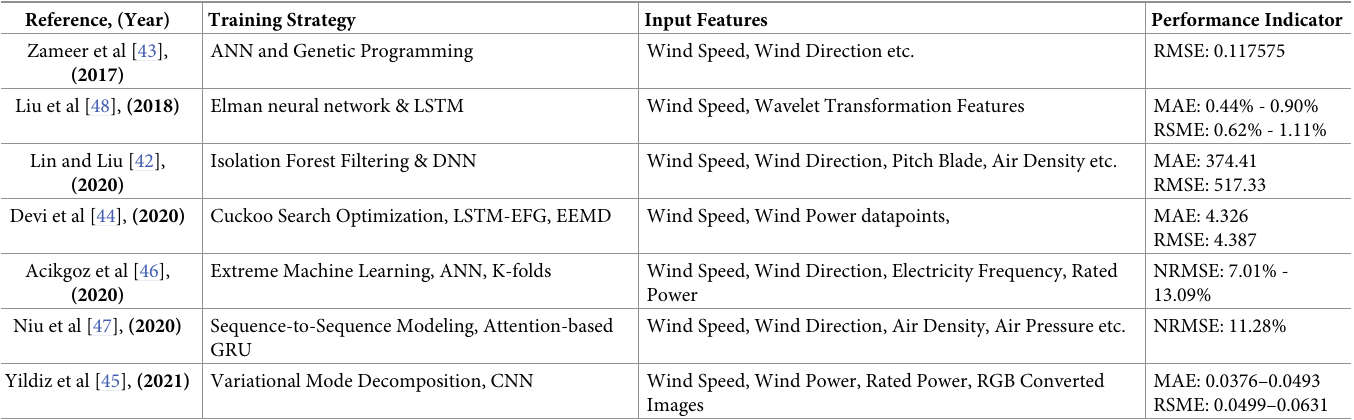
Table 1. Neural networks and input features used in previous recent